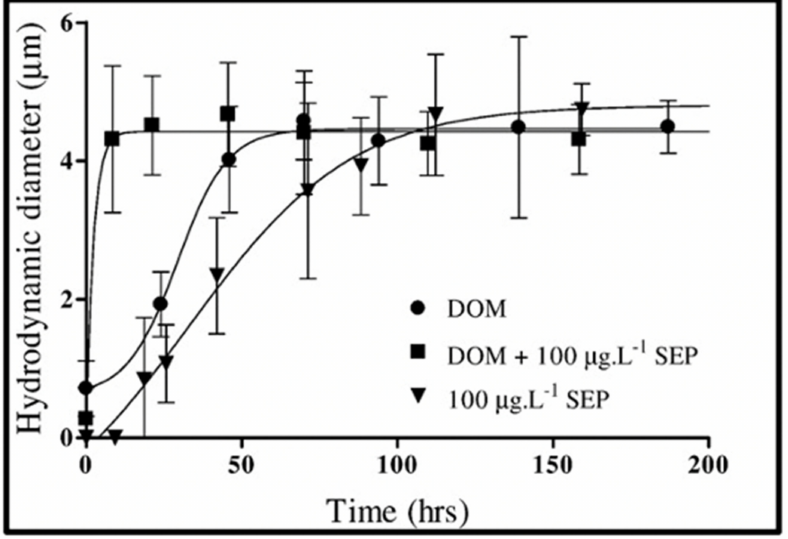
Figure 17. Assembly kinetics of DOM polymers in 0.2 µ m-filtered seawater (circles) and self-assembly of SEP (100 µ g × L − 1 in ASW (triangles) monitored by DSL. Addition of 100 µ g × L − 1 to 0.2 µ m- filtered seawater results in quick DOM assembly that reaches equilibrium in ~10 h yielding microgels of ~4–5 µ m hydrodynamic diameter (squares). Points are the average ± SD of 15 outcomes of triplicate measurements in five